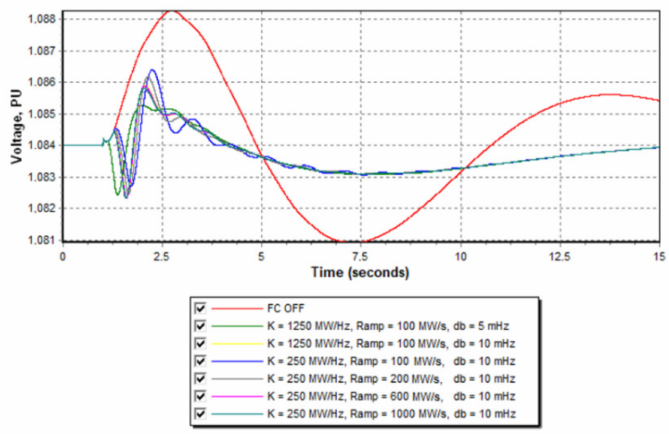
Figure 16. Voltage fluctuations on the 330 kV